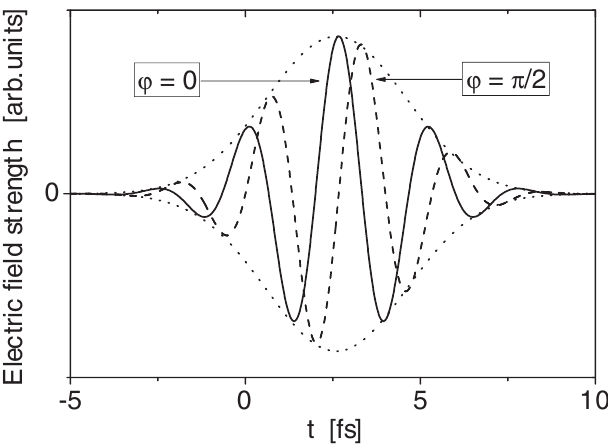
FIG. 5. Possible evolutions of the electric field in the 5-fs pulse carried at a wavelength 800 nm for two different pulse phases ( (cid:8) (cid:3) 0 ; (cid:1)= 2 ).